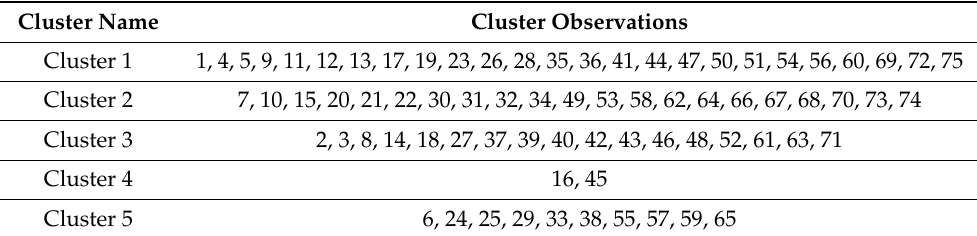
Figure 17. The star glyph plots created for visualizing multidimensional wind speed data [16]. Table 2. The province categorized into each cluster by the k-means approach [16].